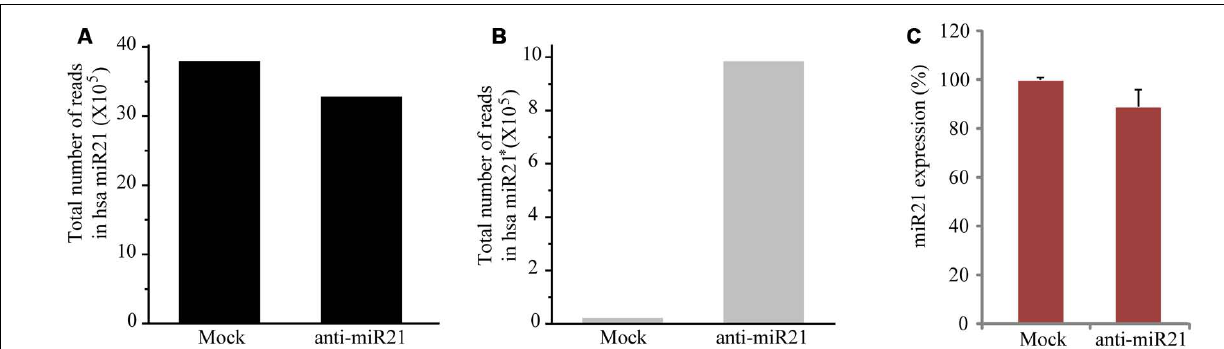
FIGURE 2 | Expression level of miR21 and miR21 ∗ . Total counted number of deep-sequencing reads containing a corresponding sequence to miR21 (A) and miR21 ∗ . ∗ indicates the small RNA processed from the hairpin arm opposite the mature miR21. (B) from HCT116-GFP cells transfected with